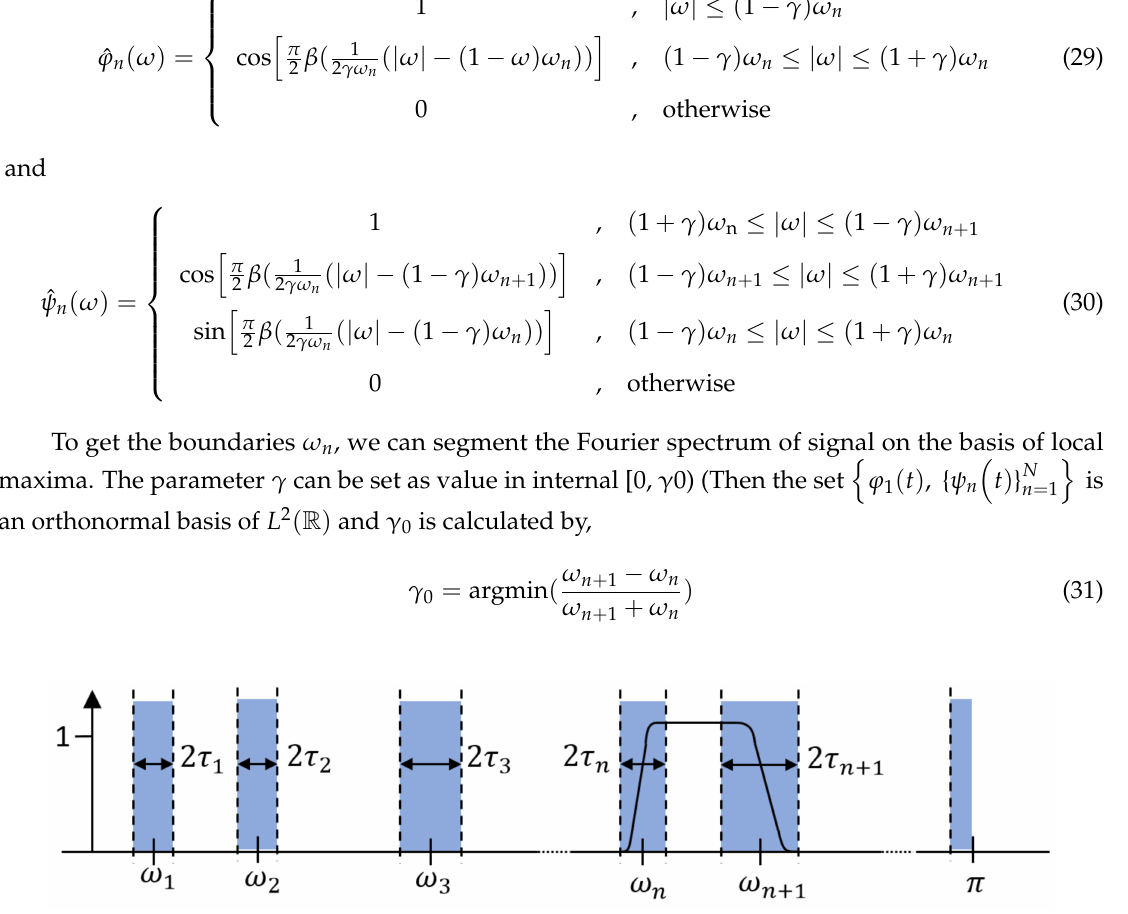
Figure 22. Segmenting Fourier spectrum into N contiguous